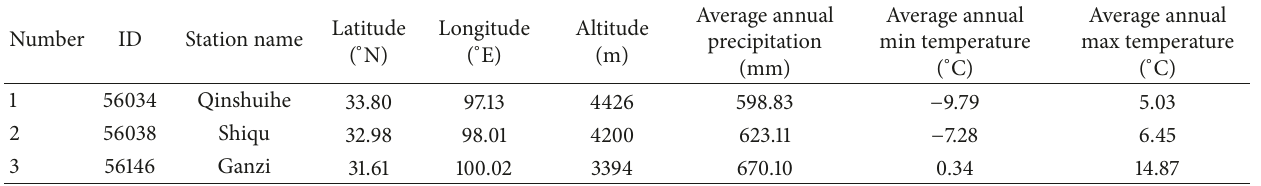
Figure 1: (a) (left) Location of GRB in China with meteorological and hydrological stations and (right) the DEM map of GRB; (b) land use; and (c) soil type. Table 1: The main characteristics of meteorological ground-based stations across